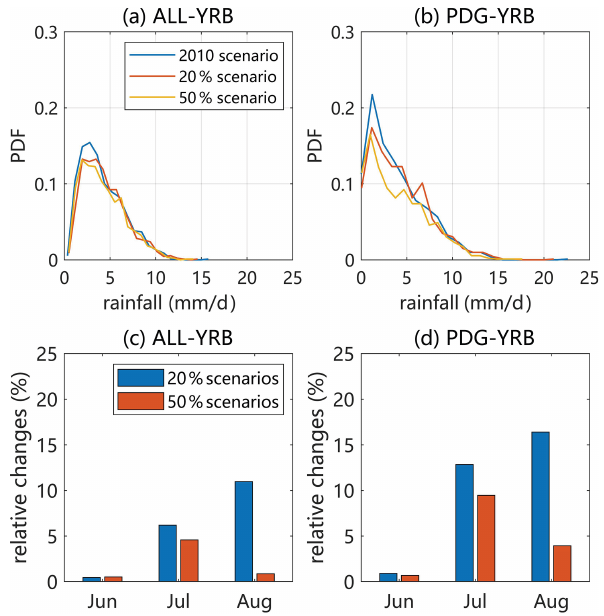
Figure 12. The probability distribution functions of summer rainfall in 2010, 20%, and 50% scenarios in (a) ALL-YRB and (b) PDG- YRB. The changes in multiyear-averaged summer monthly rainfall between the two hypothetical scenarios (20% and 50% scenarios) and the 2010 scenario in (c) ALL-YRB and (d)